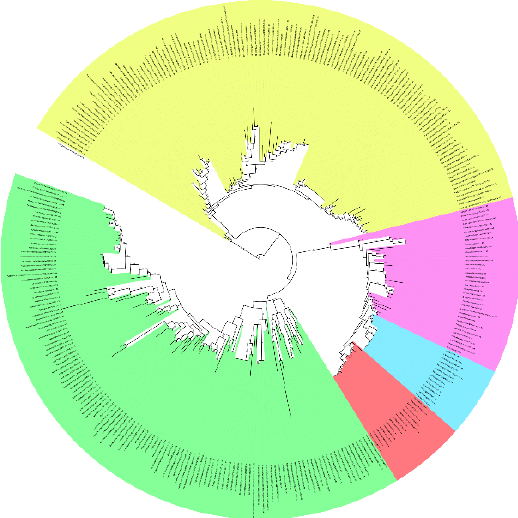
Figure 2. Maximum likelihood-estimated phylogeny for VKOR family based on VKORloop sequences for 327 non-redundant sequences (pruned to 310 sequences). Five major clades are shown in color (yellow, non-photosynthetic prokaryotes; green, photosynthetic prokaryotes and plants; magenta, primitive single-celled animals and invertebrates; blue, vertebrate VKORC1L1 homologs; red, vertebrate VKORC1 homologs. Tree is rooted using